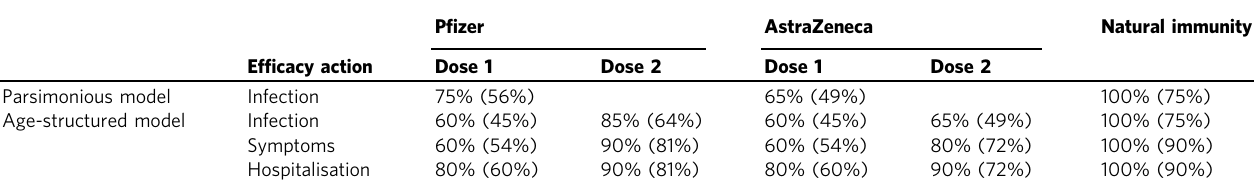
Table 3 Ef fi cacy assumptions against the resident variants and for our illustrative Variants of Concern (VOCs) with immune ecscape (VOC E and VOC LT + E, with ef fi cacies for these VOCs stated in parentheses). We computed the ef fi cacies against VOCs as the product of the proportional vaccine ef fi cacy and the ef fi cacy against the resident variants. For a summary table of source studies, see Supplementary Table